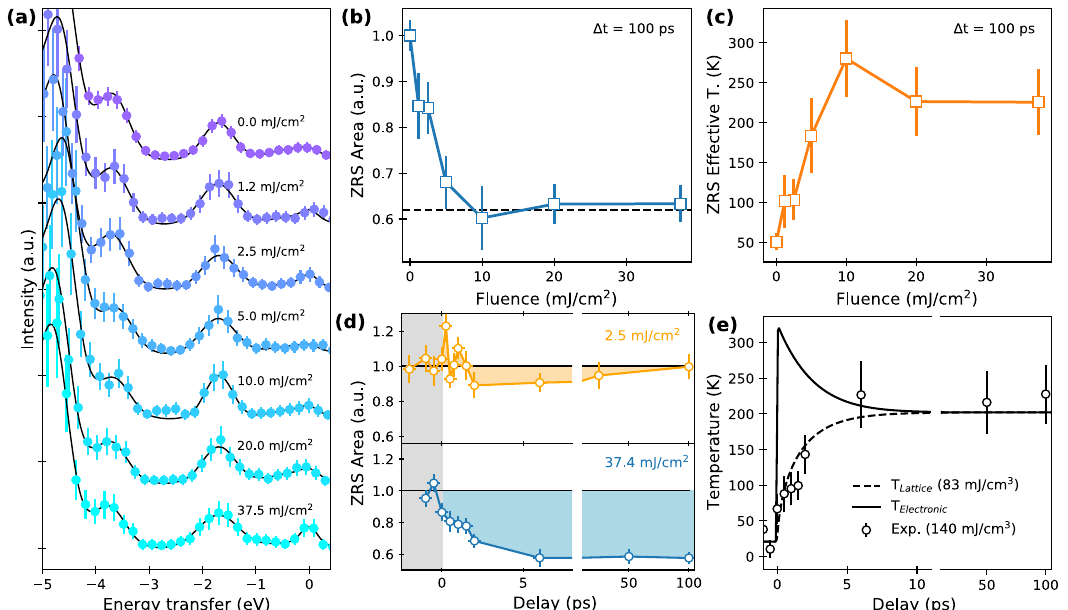
Fig. 3 Fluence dependent dynamics and effective temperature. a O K -edge RIXS spectra (markers) presented as a function of the pump fl uence at Δ t = 100 ps. Spectra are shown with a vertical offset for clarity. The black solid line represents the best fi t curve. b Fluence dependence of the integrated intensity of the ZRS excitation, exhibiting saturation for F > 5 mJ cm − 2 marked by the dashed line. The error bars represent the con fi dence interval from the least-square fi t. c Fluence dependence of the effective ZRS temperature extrapolated using the static temperature dependence of the ZRS (see Supplementary Note 3). The saturation of the ZRS signal occurs below the room temperature value. d Time trace of the integrated intensity of the ZRS for two different laser fl uences. Data are normalized to the average value at negative time-delays. Data at different fl uence is shown with separated panels for clarity. e Two-temperature model describing the energy transfer between the electronic and lattice subsystems (see Supplementary Note 3). The solid line shows the electronic temperature, the dashed line the lattice temperature, while the white markers are experimental points. The absorbed heat content estimated for the experiment and the one used in the calculation are indicated in brackets in the